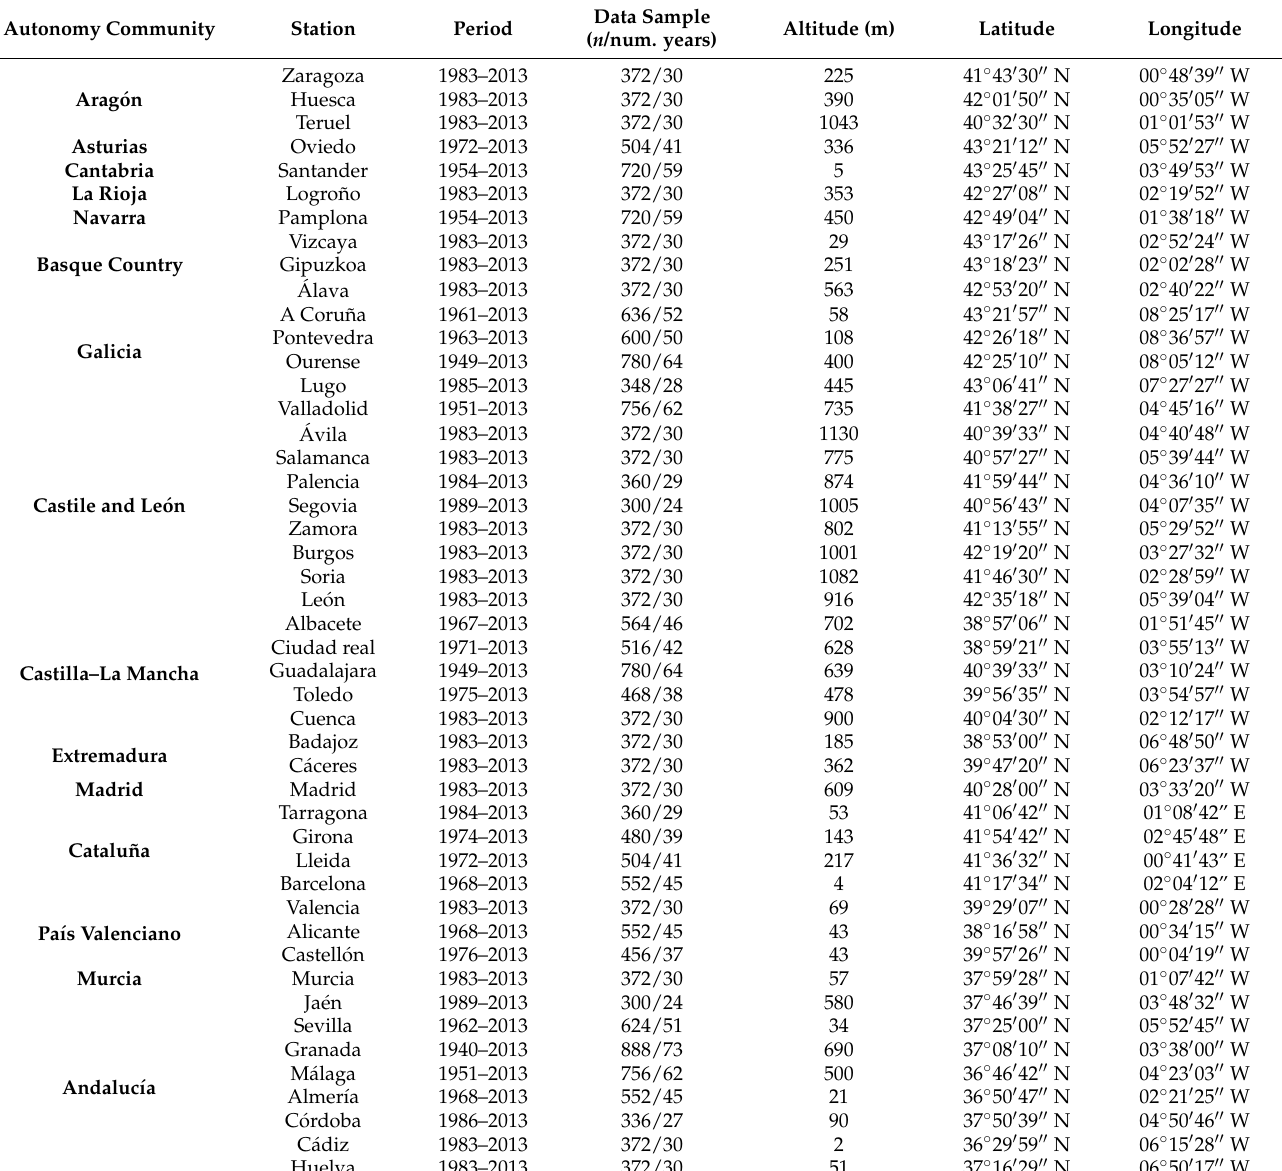
Table 1. Information of the stations of the AEMET in provincial capitals, sample size, and period of data availability in this study for both